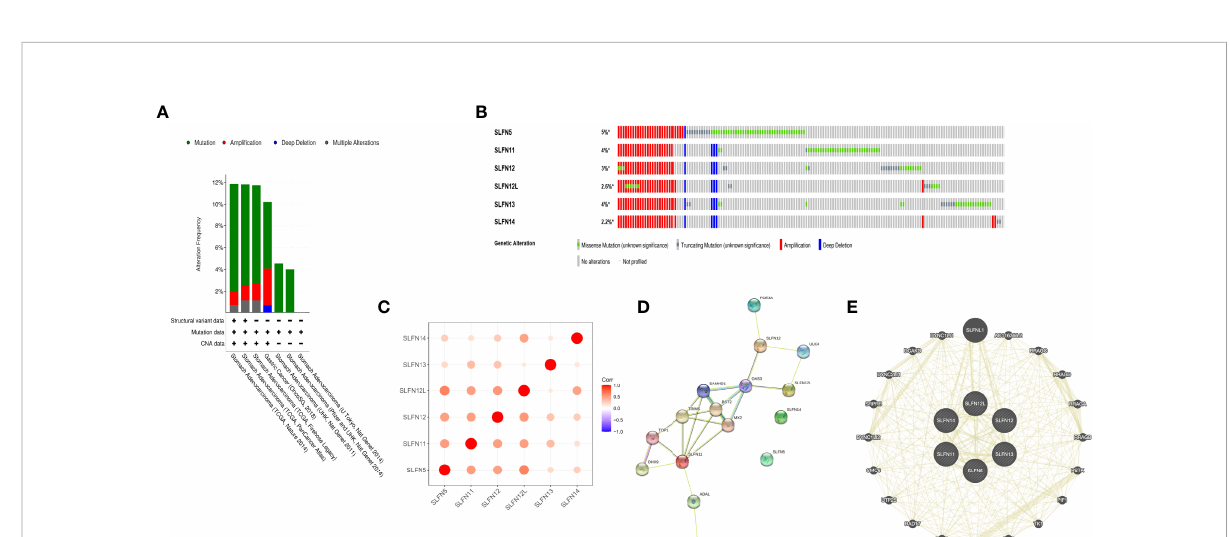
FIGURE 4 Genome changes and interaction network of SLFN family. (A, B) Genomic changes of SLFN gene families. (C) Correlation analysis among SLFN family members. (D) STRING generates PPI network of SLFN gene family. (E) GeneMania was used to construct SLFN family gene-gene interaction